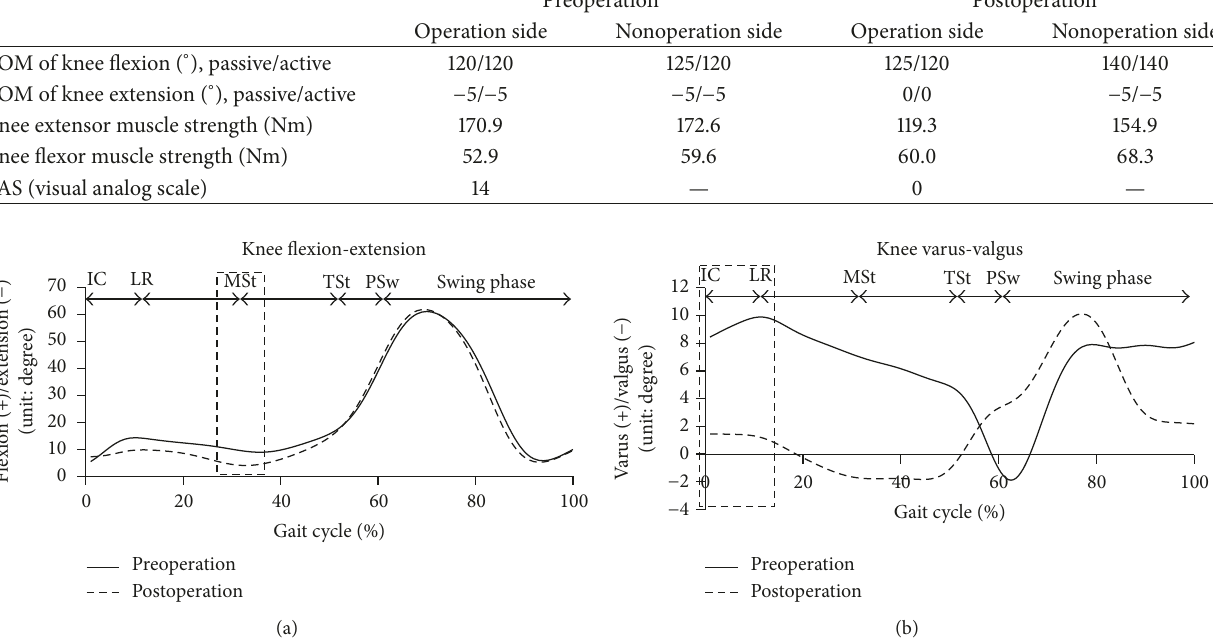
Figure 2: Kinematics of the gait analysis, pre- and postoperative. (a) represents knee flexion-extension and (b) represents knee varus-valgus during gait cycle. The part surrounded by the square in the figure shows the feature of knee kinematics change.